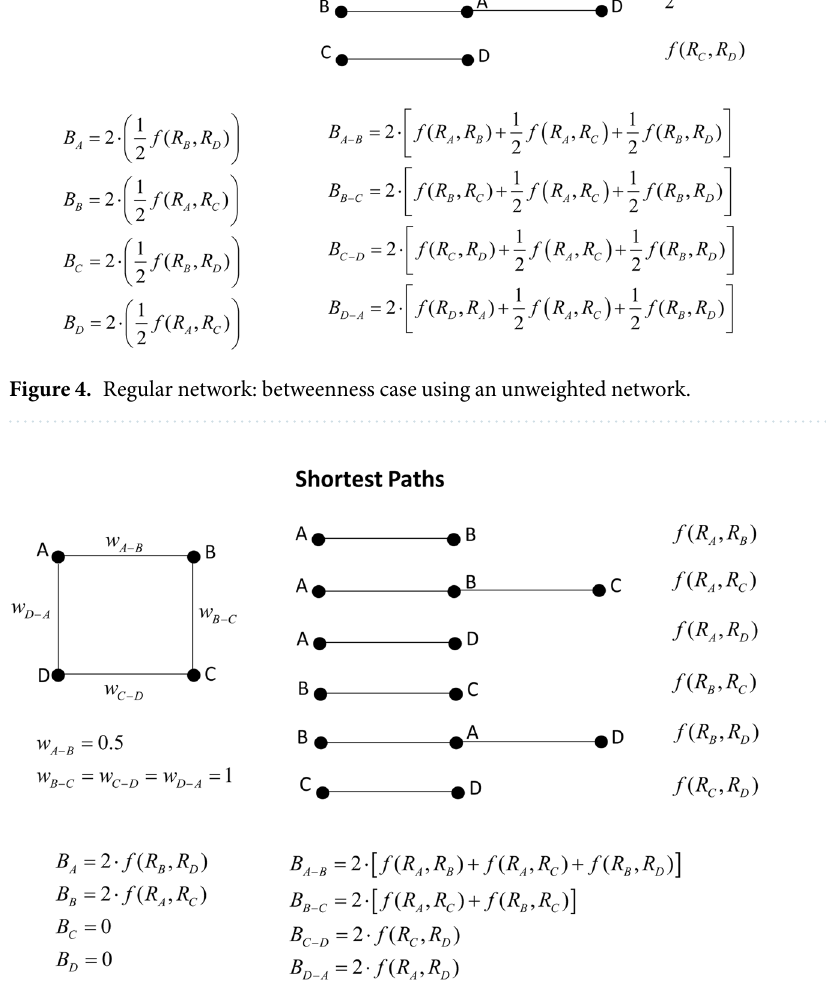
Figure 5. Regular network: betweenness case using a weighted